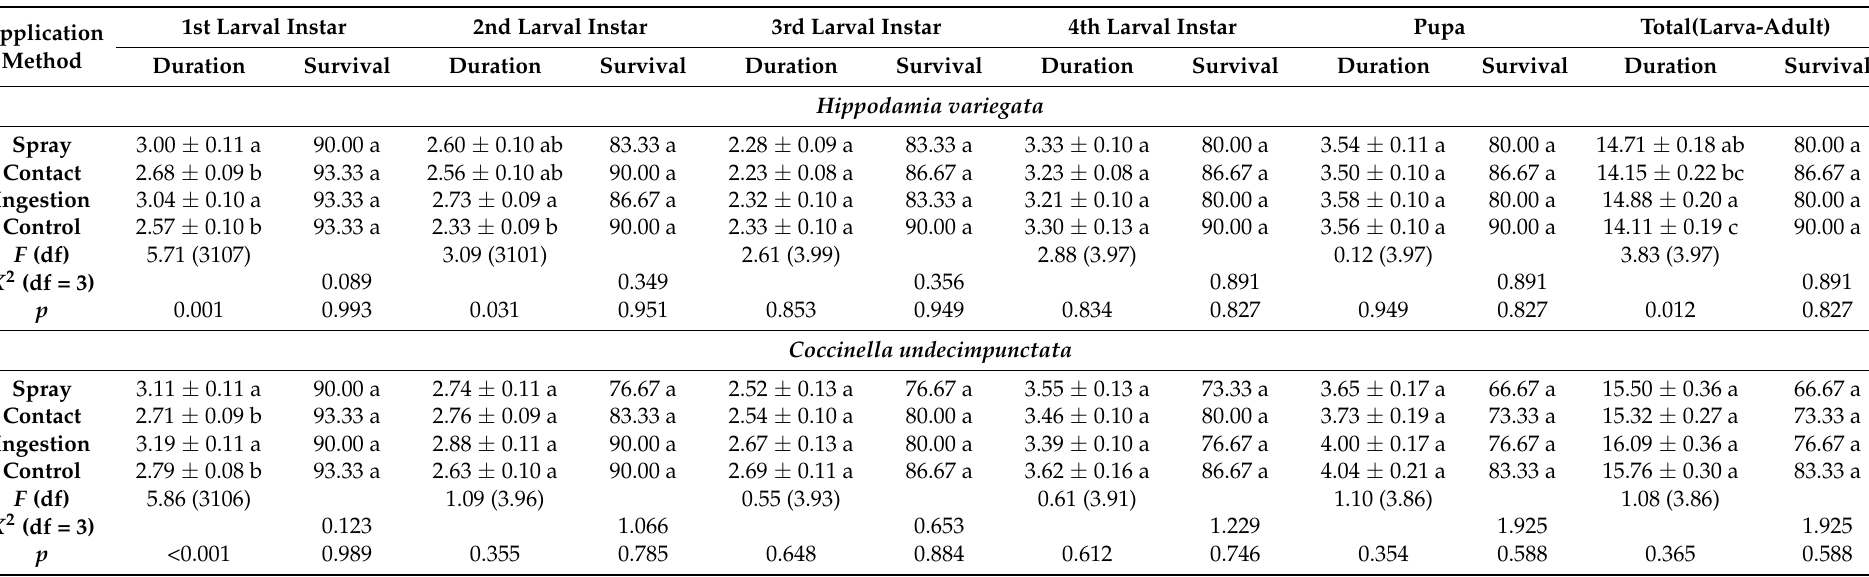
Table 1. Effect of Beauveria bassiana on the developmental time (days ± standard error) and cumulative survival (%) of larva, pupa, and adults of Hippodamia variegata and Coccinella undecimpunctata treated at their 1st larval instar with three different application methods of the